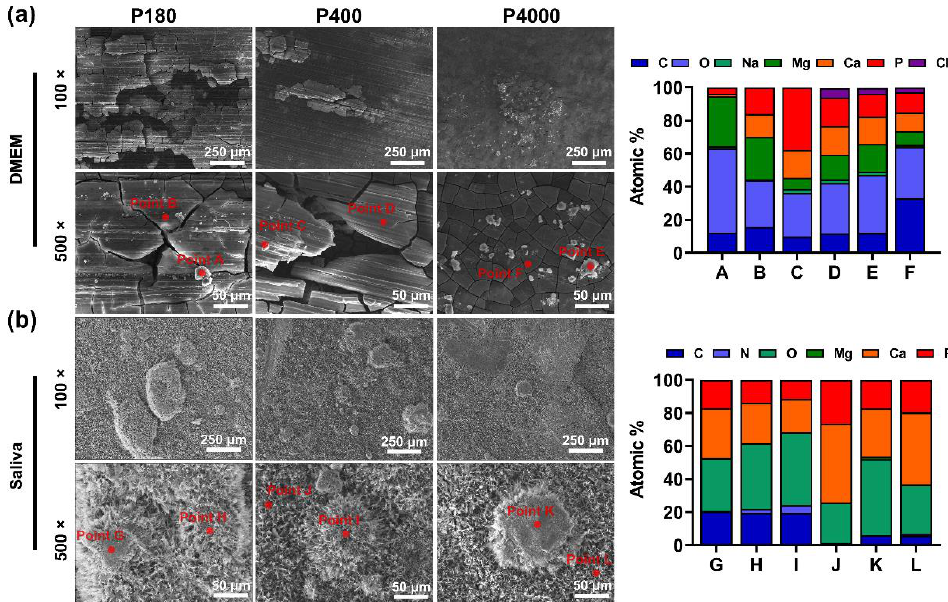
Figure 2. Surface morphology characteristics and chemical composition of samples after immersion test. ( a ) Representative SEM images (scale bar = 250 µ m and 50 µ m, magnification 100 × and 500 × , respectively). Surface chemical composition corresponding to the red point A-F of immersing in simulated body fluid. ( b ) Representative SEM images (scale bar = 250 µ m and 50 µ m, magnification 100 × and 500 × , respectively). Surface chemical composition corresponding to the red point G-L of immersing in artificial saliva detected by EDS.